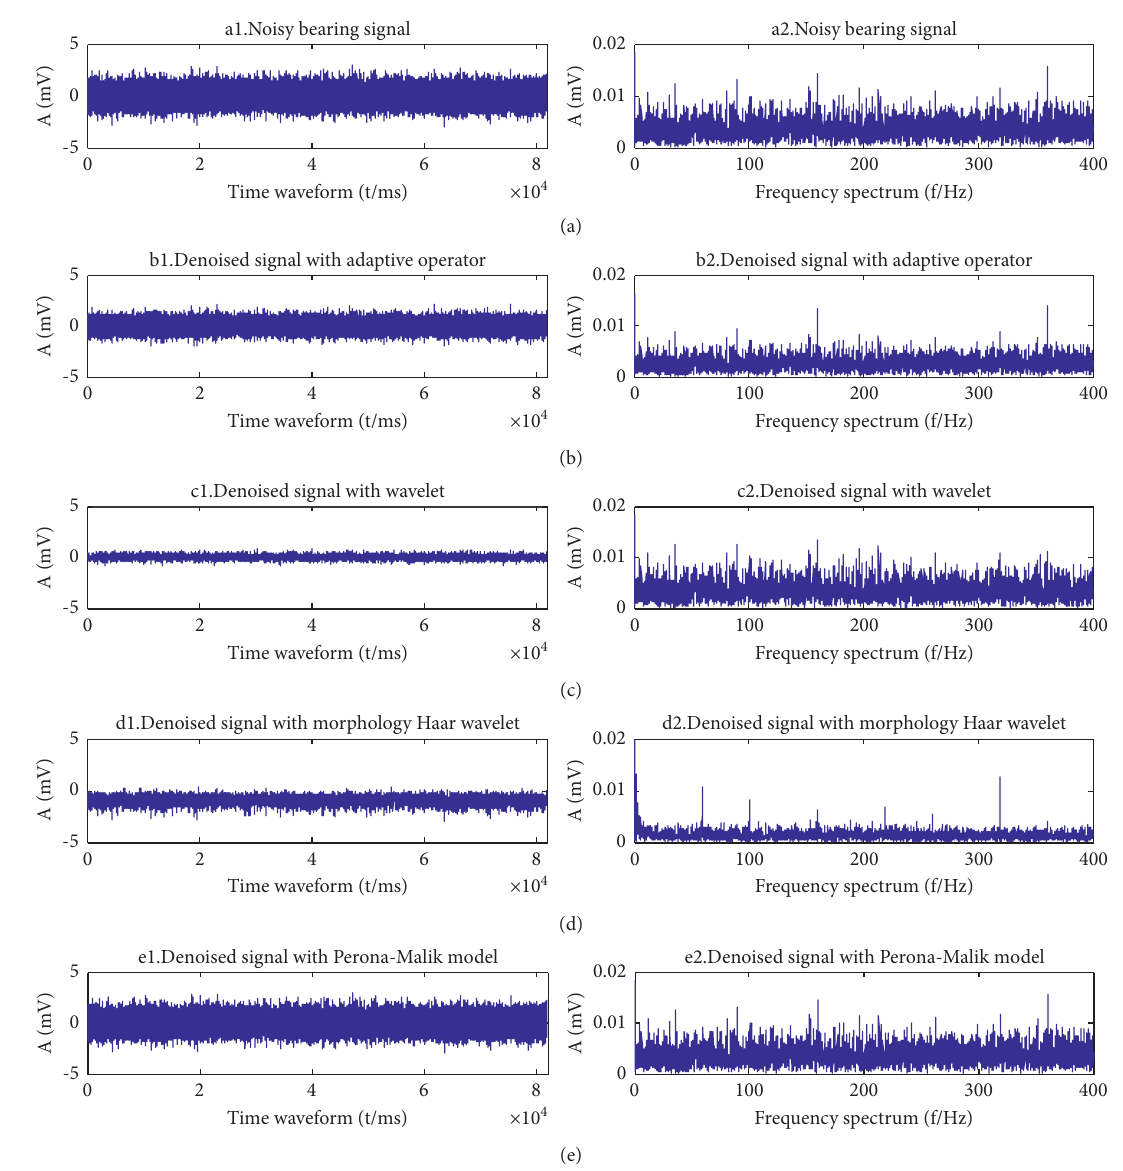
Figure 5: CWRU measured data. (a) Noisy bearing signal. (b) Denoised signal with adaptive operator. (c) Denoised signal with wavelet. (d) Denoised signal with morphology Haar wavelet. (e) Denoised signal with Perona–Malik